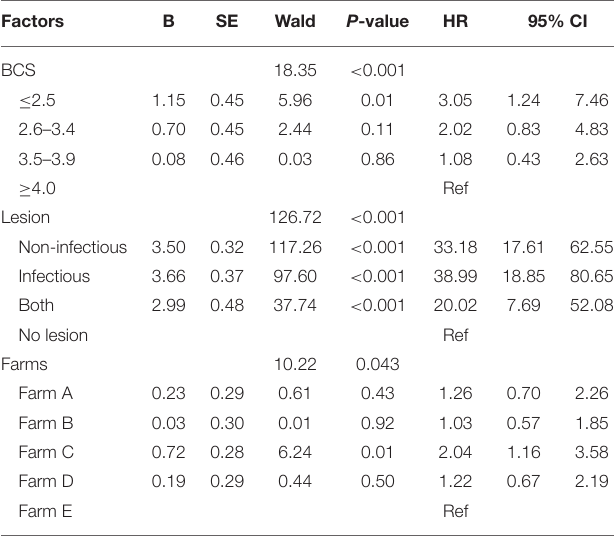
TABLE 4 | Final multivariable cox regression models for factors associated with time to first lameness event in 476 cows from five farms in Peninsular